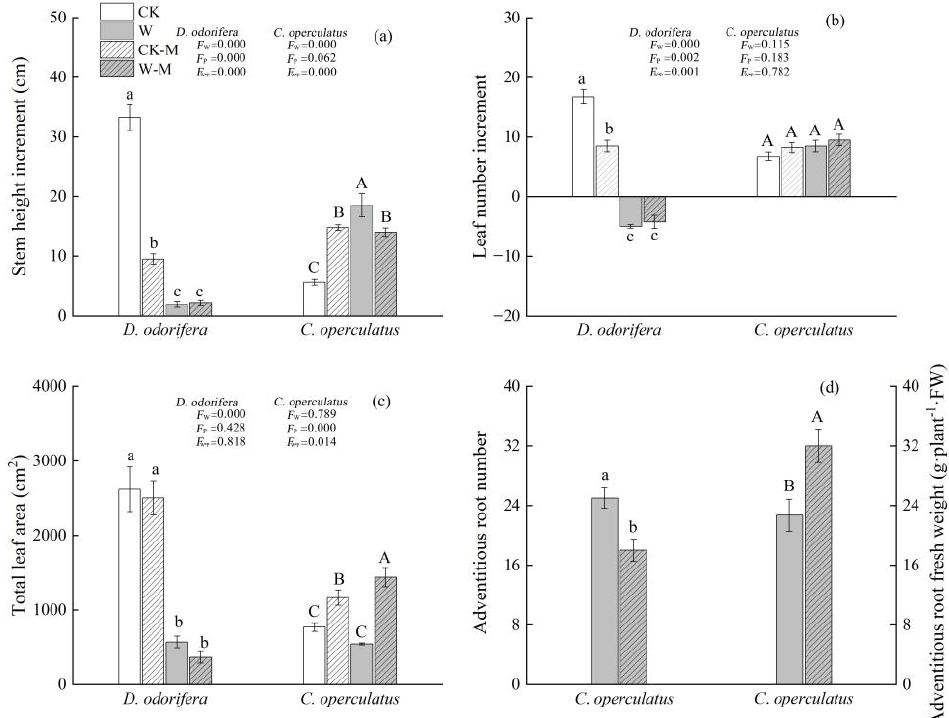
Figure 1. Comparative analyses of the stem height increment ( a ), leaf number increment ( b ), total leaf area ( c ), and adventitious root number and weight ( d ) of C. operculatus and D. odorifera under all treatments. CK, single planting under well-watered condition; W, single planting under waterlogging condition; CK-M, mixed planting under well-watered condition; W-M, mixed-planting under water- logging condition. Values are means ± SE (n = 5). Different letters above the bars denote significant differences at the p < 0.05 level according to Duncan’s test. FW, waterlogging effect; FP, planting effect; FW*P, waterlogging × planting